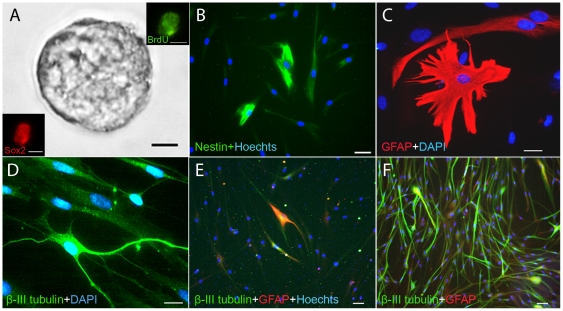
Human FT cells in culture. (A) Neurosphere after second passage.BrdU-positive (green) and Sox2-positive (red) cells in neurosphere from human FT (Insert in A). (B) Nestin-positive cells (green) after 28 days with nuclear marker Hoechst (blue). (C) GFAP-positive cells with astroglial shape (red) and (D) One neuronal (β-III-tubulin) cell as it appears after 11 days of differentiation (blue = DAPI). (E) Expansion of cells without PDGF-BB. (F) Cells expanded in culture medium exposed to PDGF-BB for 8 days, GFAP (red), β-III tubulin (green) and nuclear marker Hoechst (blue). Bars: A and B = 10 μm, Insert = 25 μm, C and D = 5 μm and E−F = 20 μm.